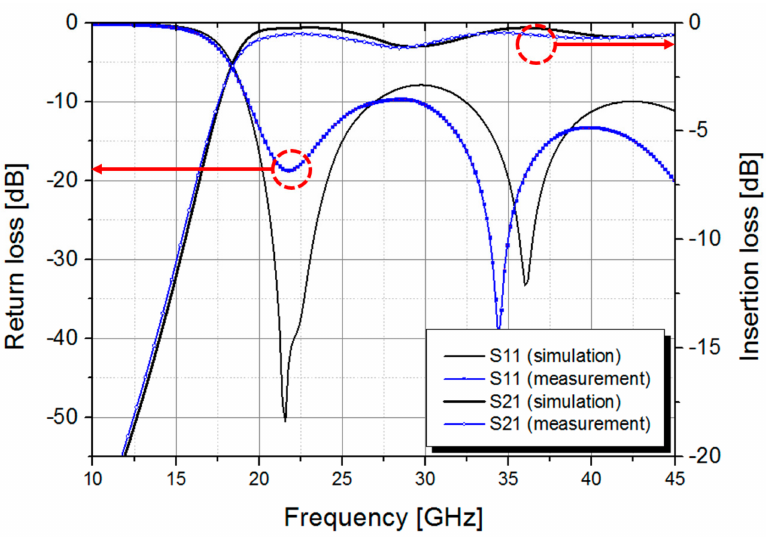
Figure 5. Simulated and measured S -parameters of the fabricated SIW.